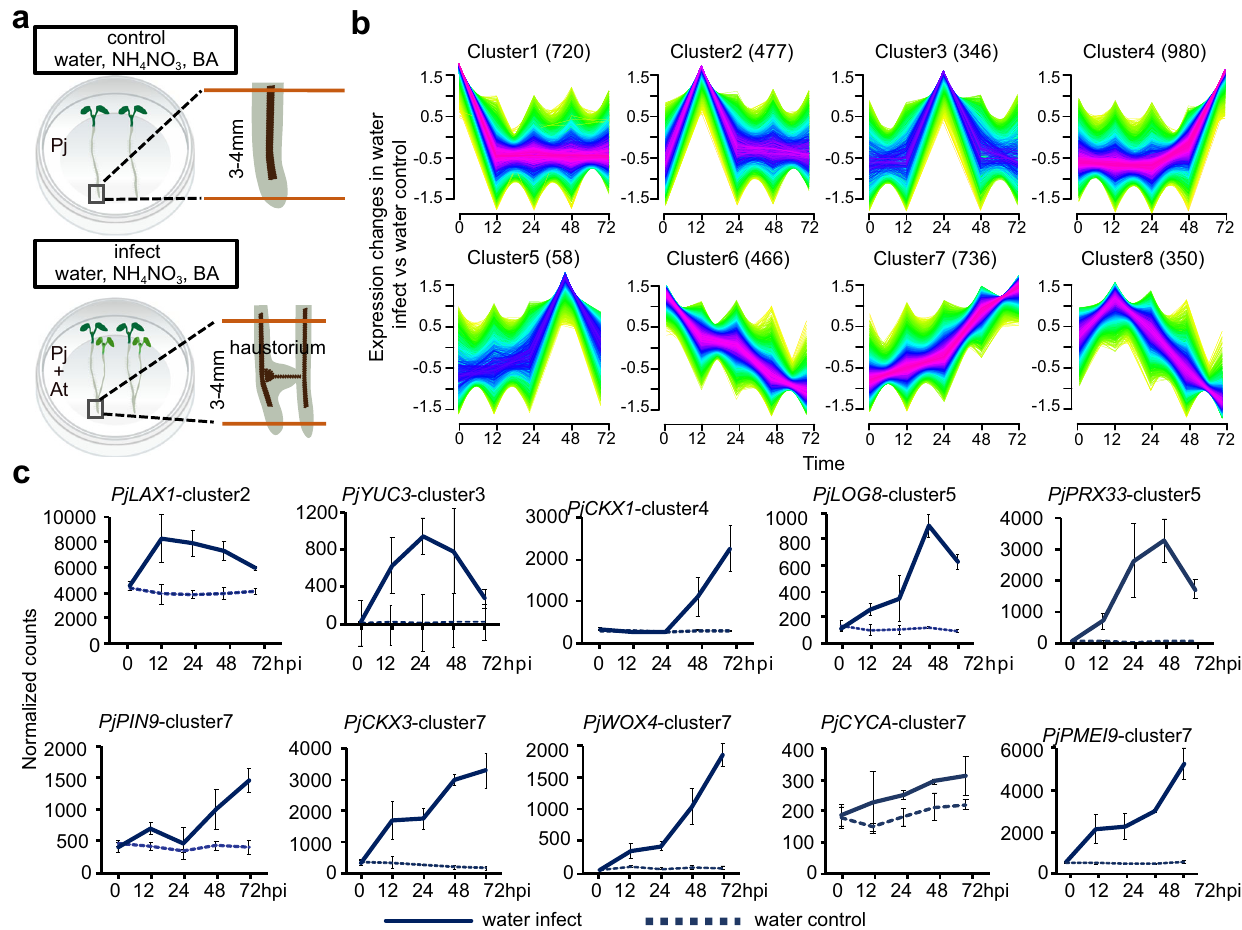
Fig. 2 Transcriptomic changes during haustorium formation. a Illustration describing the set-up for the RNAseq experiment. P. japonicum and Arabidopsis (infect) or P. japonicum alone (control) were placed on media containing water, 10.3 mM NH 4 NO 3 or 0.08 μ M BA; 3 – 4 mm of root tip or haustorium formation area was harvested at 0, 12, 24, 48, 72 hpi time points for the water treatment and 0, 12, 24 hpi time points for the NH 4 NO 3 and BA treatments. b Clustering of differentially expressed genes in the water infect treatment based on their co-expression patterns over fi ve time points; numbers in parentheses represent the number of genes in the cluster. c Normalized P. japonicum counts of PjYUC3, PjLAX1, PjPIN9, PjWOX4, PjPMEI9, PjCKX1, PjCKX3, PjLOG8, PjCYCA, PjPRX33 over 5 time points in the water infect treatment (mean ± SD, n = 3 libraries). (Fig. 2b, Supplementary Fig. 2b, Supplementary Data 1). Cluster 2, 3 ( PjPRX33 ) were upregulated as well (Fig. 2c) indicating substantial transcriptional reprogramming as the haustoria formed.